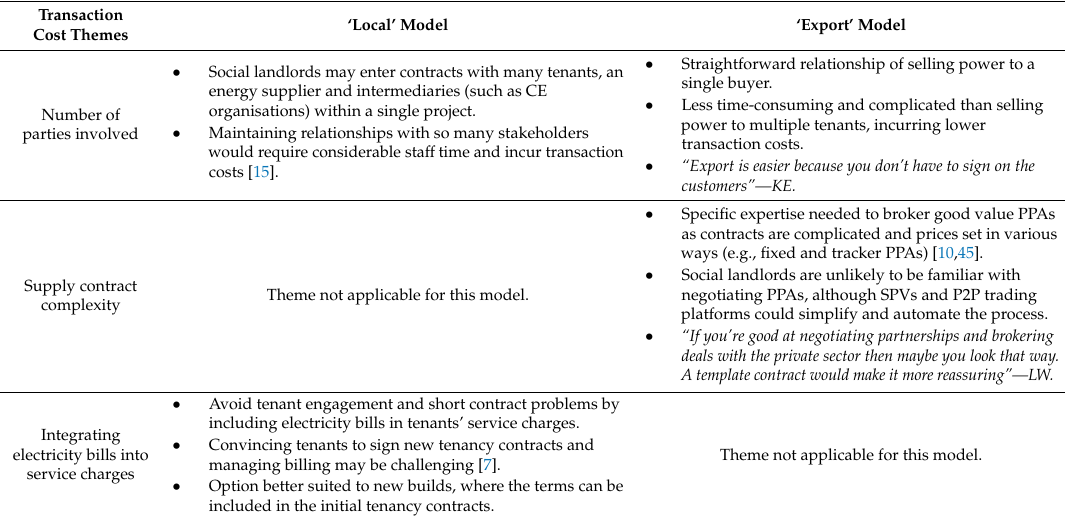
Table 5. Tenant benefit themes for both models from interview transcript analysis. Tenant Benefit